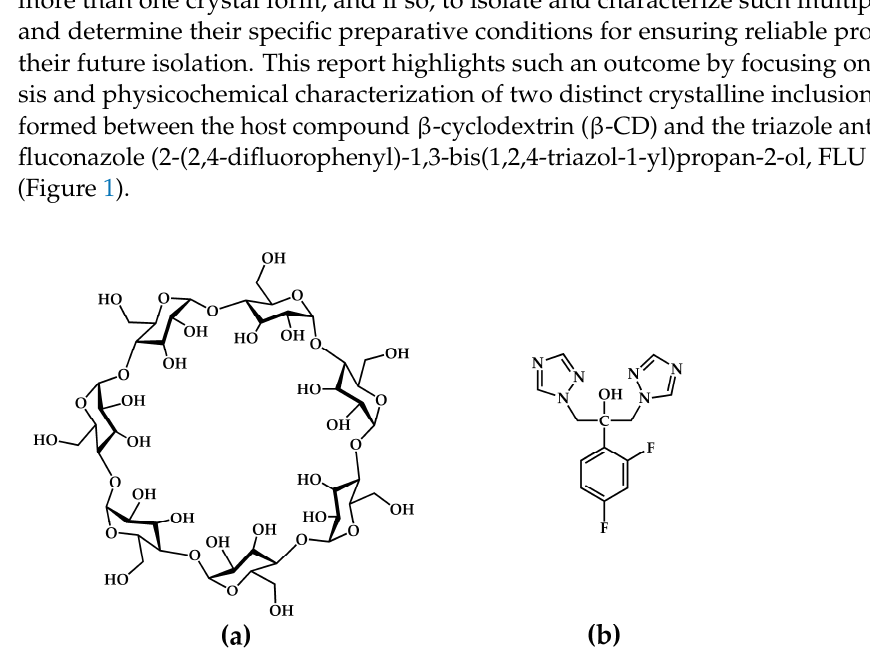
Figure 1. Chemical structures of ( a ) the host compound β -cyclodextrin and ( b ) the API fluconazole. β -CD, a prominent member of the native (natural/underivatized) cyclodextrins, is a cyclic oligosaccharide composed of seven α -1,4-linked D-glucopyranose units, frequently employed as a complexing agent to solubilize hydrophobic guest molecules [8,9]. Depend- ing on the size of the latter, the central apolar cavity of the β -CD molecule can accommo- date either an entire lipophilic guest molecule or a sizeable guest residue. On the other hand, the periphery of the toroidally shaped macrocycle features seven hydroxyl groups located on its narrower (primary) rim and fourteen hydroxyl groups on its wider (second- ary rim), these functional groups rendering the host–guest complex relatively soluble in water. The use of CDs as vehicles for the delivery of poorly soluble APIs is a major re- search topic in the fields of supramolecular chemistry and pharmaceutical development.